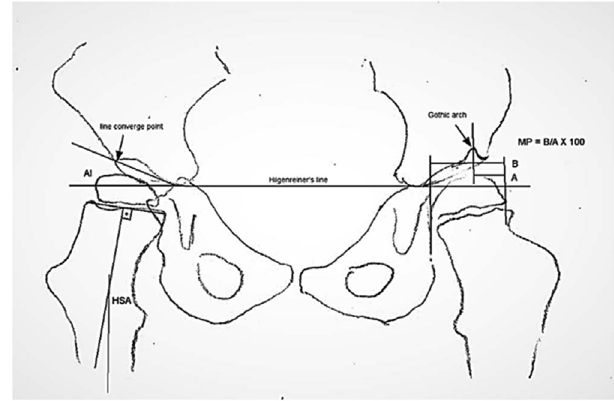
Figure 1. References for the calculation of migration percentage (MP) in the presence of a Gothic arch, acetabular index (AI) in the case of oval image, and the head-shaft angle